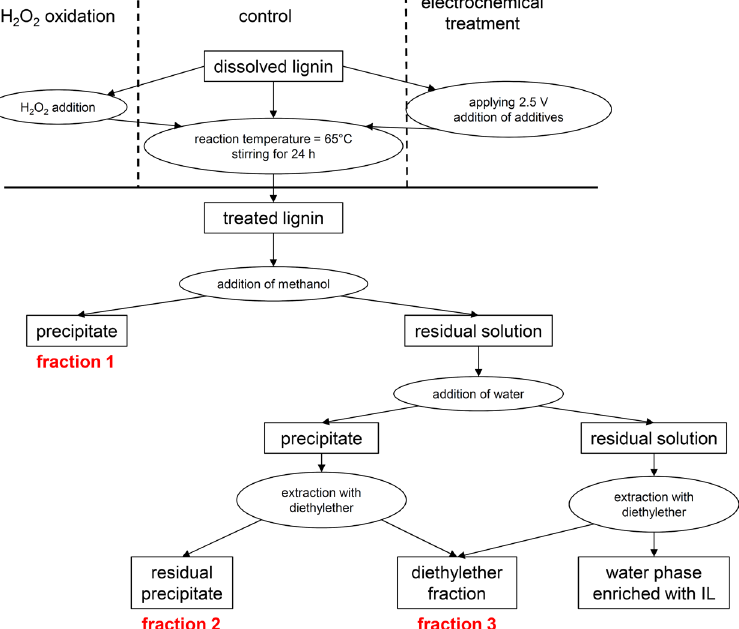
Figure 3. Schematic representation of the electrochemical degradation process including extraction